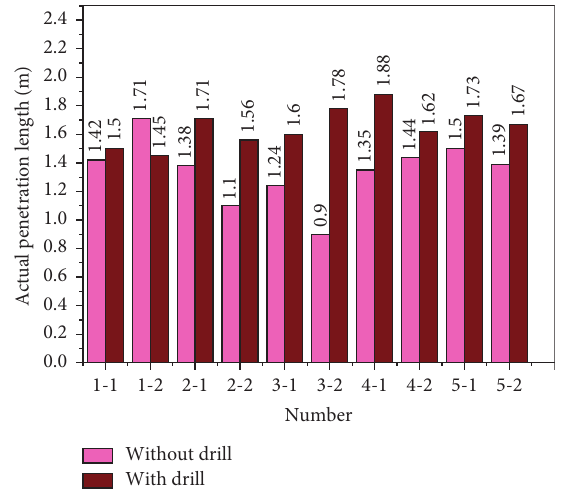
Figure 22: mm-in-diameter 25 bolt penetration depth columnar.